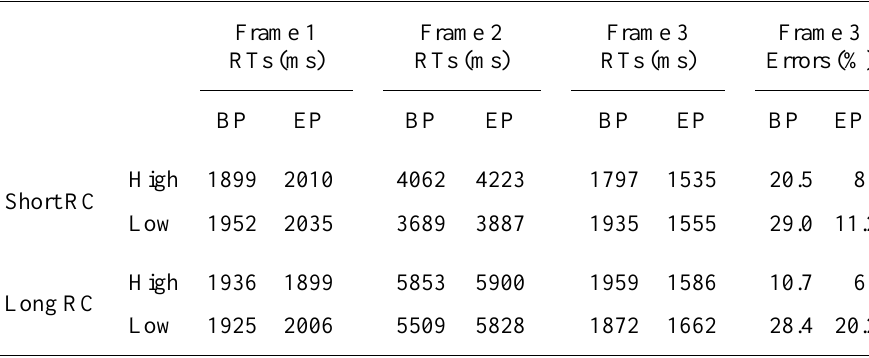
Table 1. Mean reading times (RTs) at Frames 1, 2 and 3 and error rates (Errors) at Frame 3, for BP and EP participants, as a function of RC length (short, long) and attachment (high,